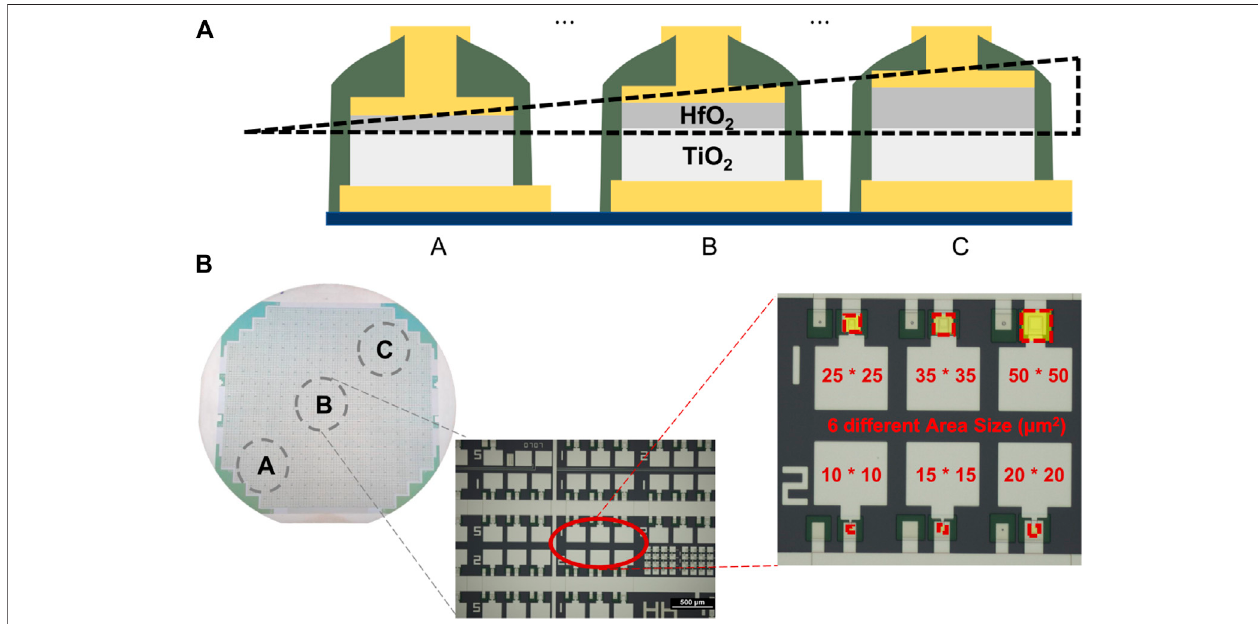
FIGURE1| Schematicrepresentationofthetechnologyforbi-layeroxidememristivedevices:Usingdifferentsputteringgeometries(referredtoasmethods1and2 inthetext),differenttypes ofdeviceshave beenproduced,showing fi lamentaryswitching(referredtoastype F)andarea-basedresistanceswitching(referredtoastype R). (A) Cross-sectionofTiN/TiO x /HfO x /Aubi-layeroxidememristivedevicesoverthewafer.Theuseddepositionmethod(method2)allowsforavariationofthethickness ofHfO x layerfrom2to8 nm. (B) Microscopeimagesofacomplete4-inchwaferwith40,000singledevicesandsections,showingtheindividualcellswhichconsist ofclusterswithsixdevices,eachwithadifferentareasize.ThreeregionsonthewaferareindicatedasA,B,andC.Eachregionhasanareasizeof0.5 × 0.5 cm 2 .Fortype Rdevicesa2 nmHfO x wasdepositedonallthethreeregions,whilethethicknessesfortypeFhave2,5,and8 nmHfO x fi lmsonregionA,B,andC,respectively.Here,it was assumed that the HfO x thickness is the same in each region due to the 1-dimensional thickness change over a 4-inch wafer and the relatively small area size. Approximately 60 memristive devices were measured in each area A, B, and C, respectively, for type F.